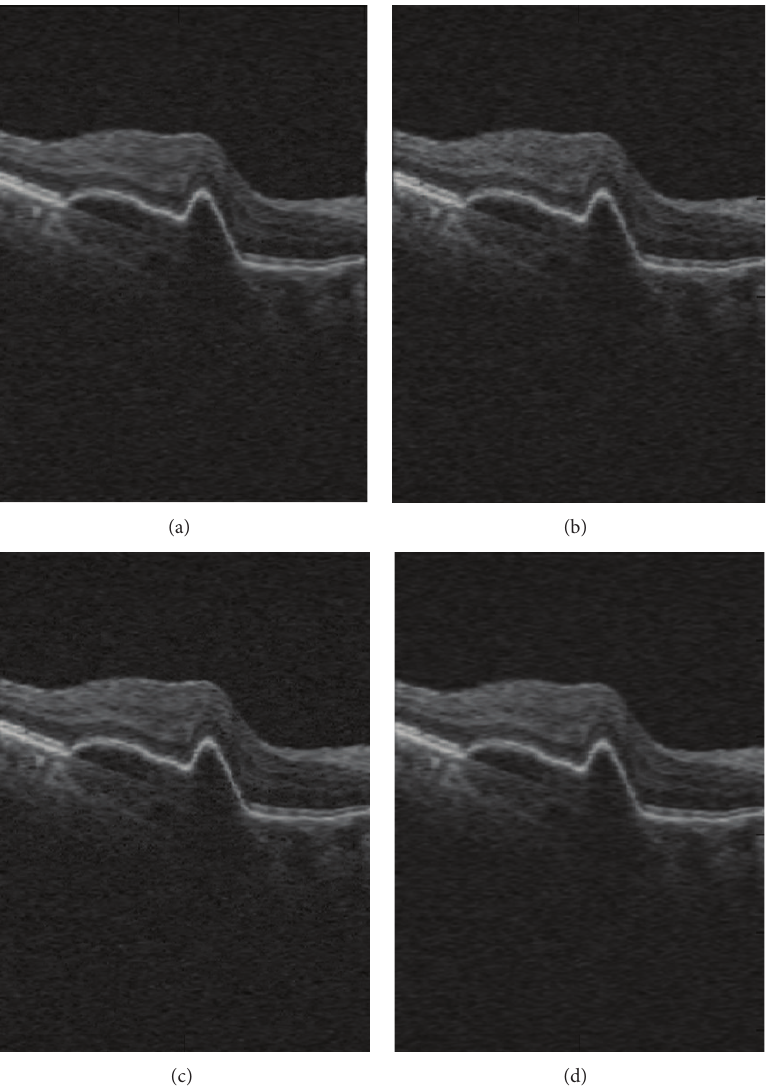
Figure 12: The results of applying non-homomorphic methods on proposed image in Figure 10. From top-left clockwise: despeckled data using BiGaussMixShrinkL, nonlocal BiGaussMixShrinkL, nonlocal BiGaussRayMixShrinkL, and